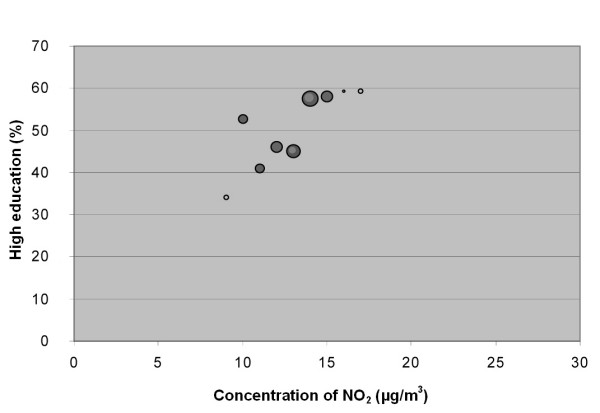
Bubble diagram for Lund; Percentage of population in Lund with high education versus annual mean concentration of NO2 at their real estate. The bubbles are sized according to the weight of the estimate, which depends on the size of the population that the estimate is based on. The weight is thus a measure of the uncertainty in the estimate, and large bubbles represent more certain and influential estimates than small bubbles.